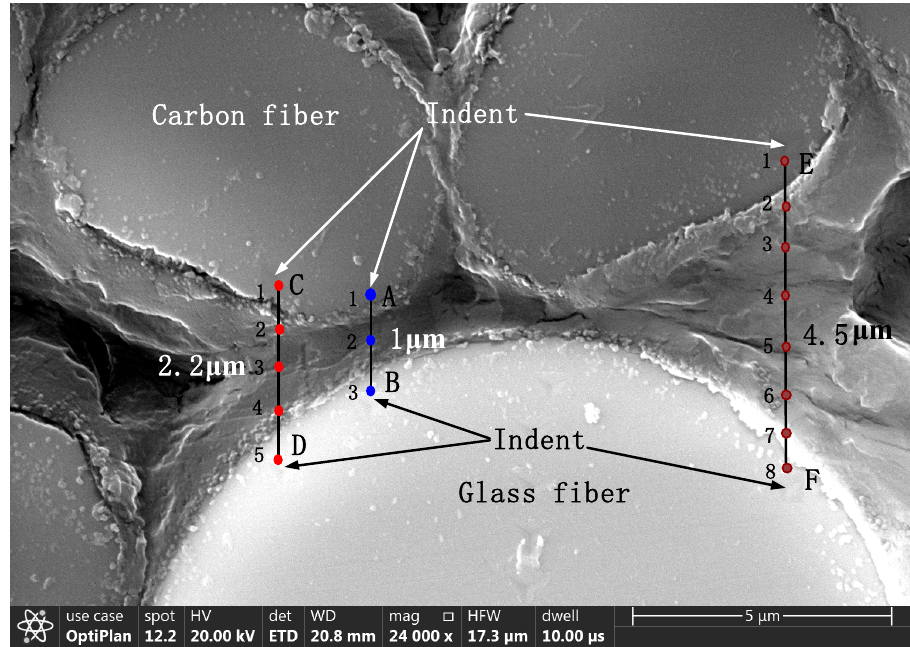
Figure 6. SEM image illustrating the positions of the different indentation measurements. Three points were tested along the AB segment: points 1 and 3 correspond to positions on the carbon and glass fibers, respectively, and their indentation values are 68 and 34 GPa, respectively; the modulus at point 2 in the middle of the AB segment is 13 GPa, which is 4.3 times that of the matrix (3 GPa). Therefore, when the distance between the two fibers is small, the modulus of the matrix between the two fibers increases due to the influence of the